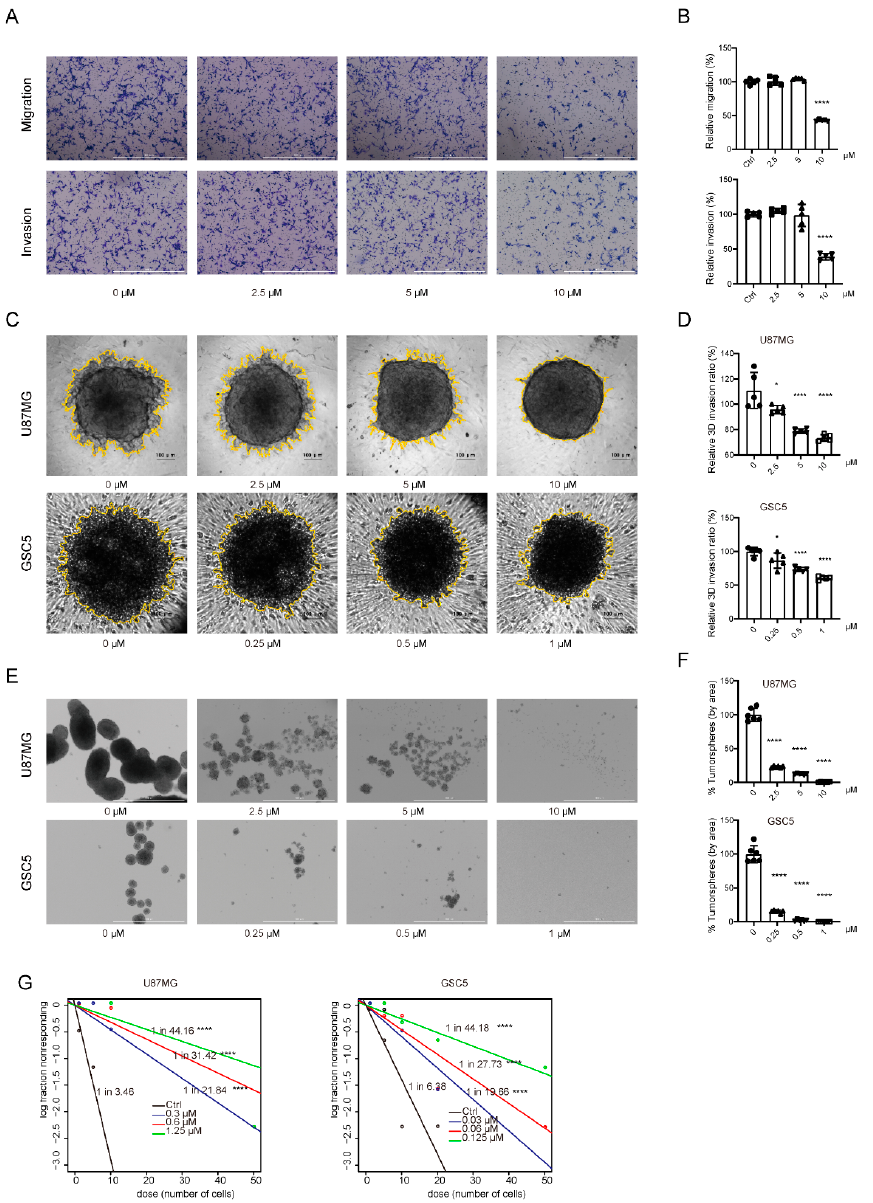
Figure 2. TAK901 suppresses the migration and invasion of GBM cells and the stemness of glioma stem cells. ( A ) Representative images of migration and invasion assays of U87MG cells treated with indicated concentrations of TAK901 for 24 h using 24-well Transwell inserts ( n = 5). Scale bar, 1000